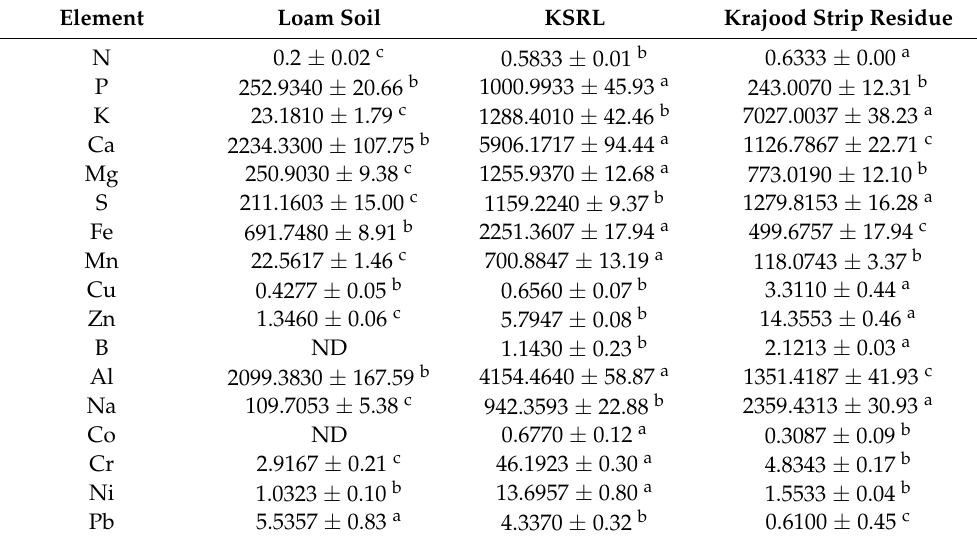
Table 5. The concentration (ppm) of major and minor elements detected in the samples. Element Loam Soil KSRL Krajood Strip Residue N 0.2 ± 0.02